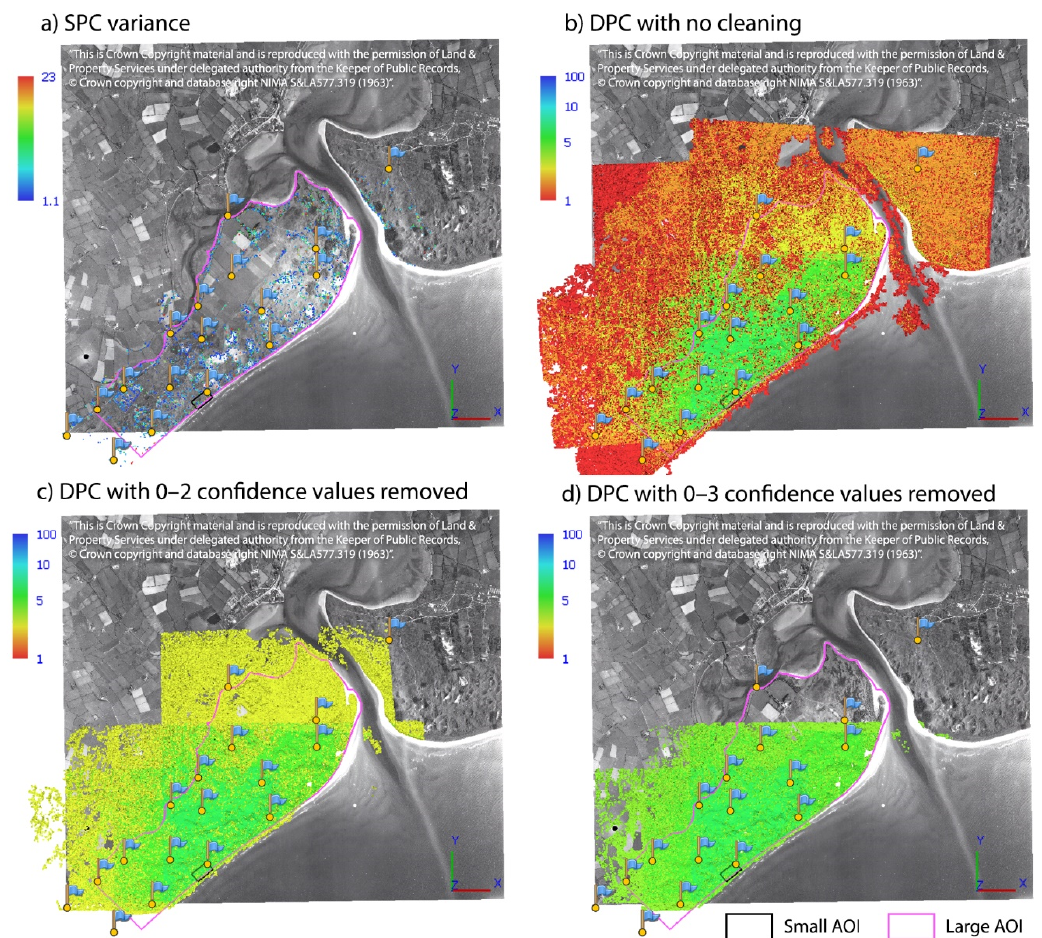
Figure 7. ( a ) Sparse point cloud (SPC or tie points) variance values from image alignment and camera optimisation for all 12 methods applied. ( b ) Dense point cloud (DPC) confidence values for the methods that did not involve cleaning of the DPC. ( c ) Dense point cloud confidence values for the methods that involved cleaning of the DPC for confidence values in the range of 0–2. ( d ) Dense point cloud confidence values for the methods that involved cleaning of the DPC for confidence values in the range of 0–3. Blue flags represent the 17 ground control points used in the structure-from-motion process. The color bars ( b – d ) are logarithmic scales. The background 1963 aerial photograph was provided by the Ordnance Survey of Northern Ireland